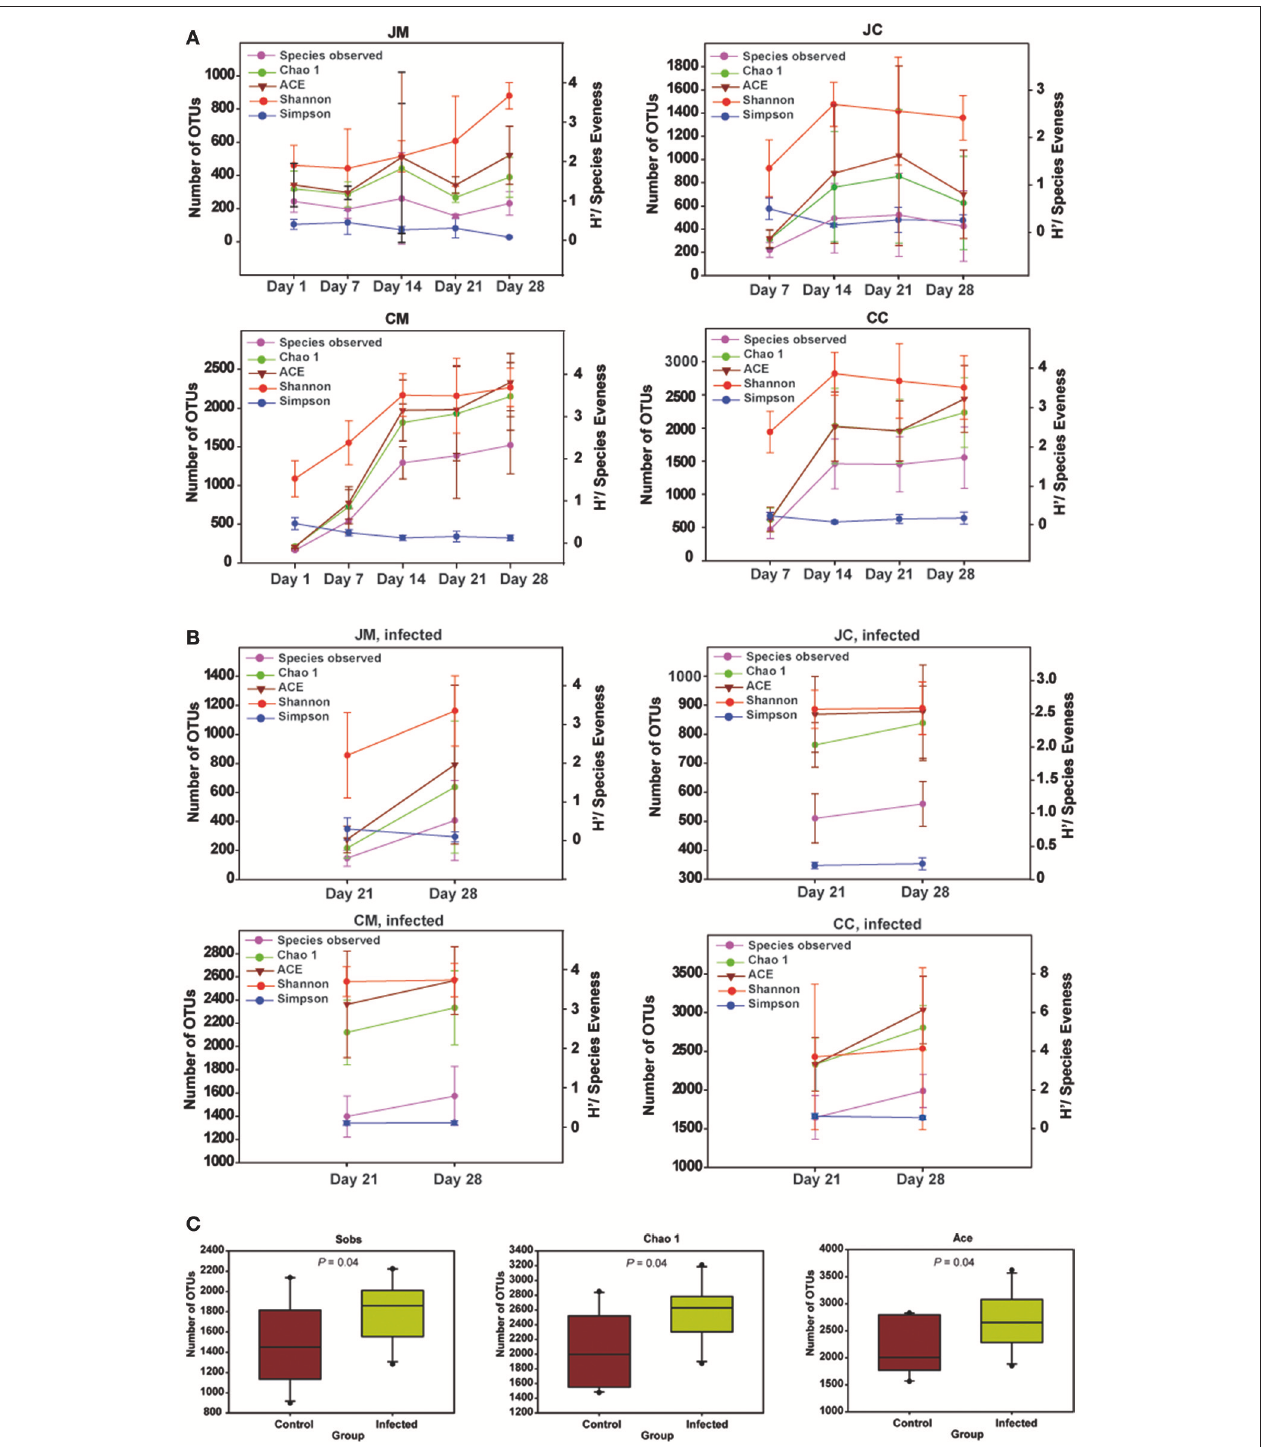
FIGURE 4 | Species richness and diversity measures of the microbial community at all gut sites in the control (A), infected birds (B) , and (C) species richness and diversity estimates for bacteria from cecum content of the infected birds compared with the controls. Left Y-axis for number of observed OTUs (Sobs), Chao 1 and ACE, and Right Y-axis for Shannon and Simpson. Significant differences were calculated with Kruskal-Wallis-tests and Mann-Whitney-tests, and significance was declared at P < 0.05. Data are presented as the mean values and SD . JM, jejunal mucosa; JC, jejunal content; CM, cecum mucosa; CC, cecum